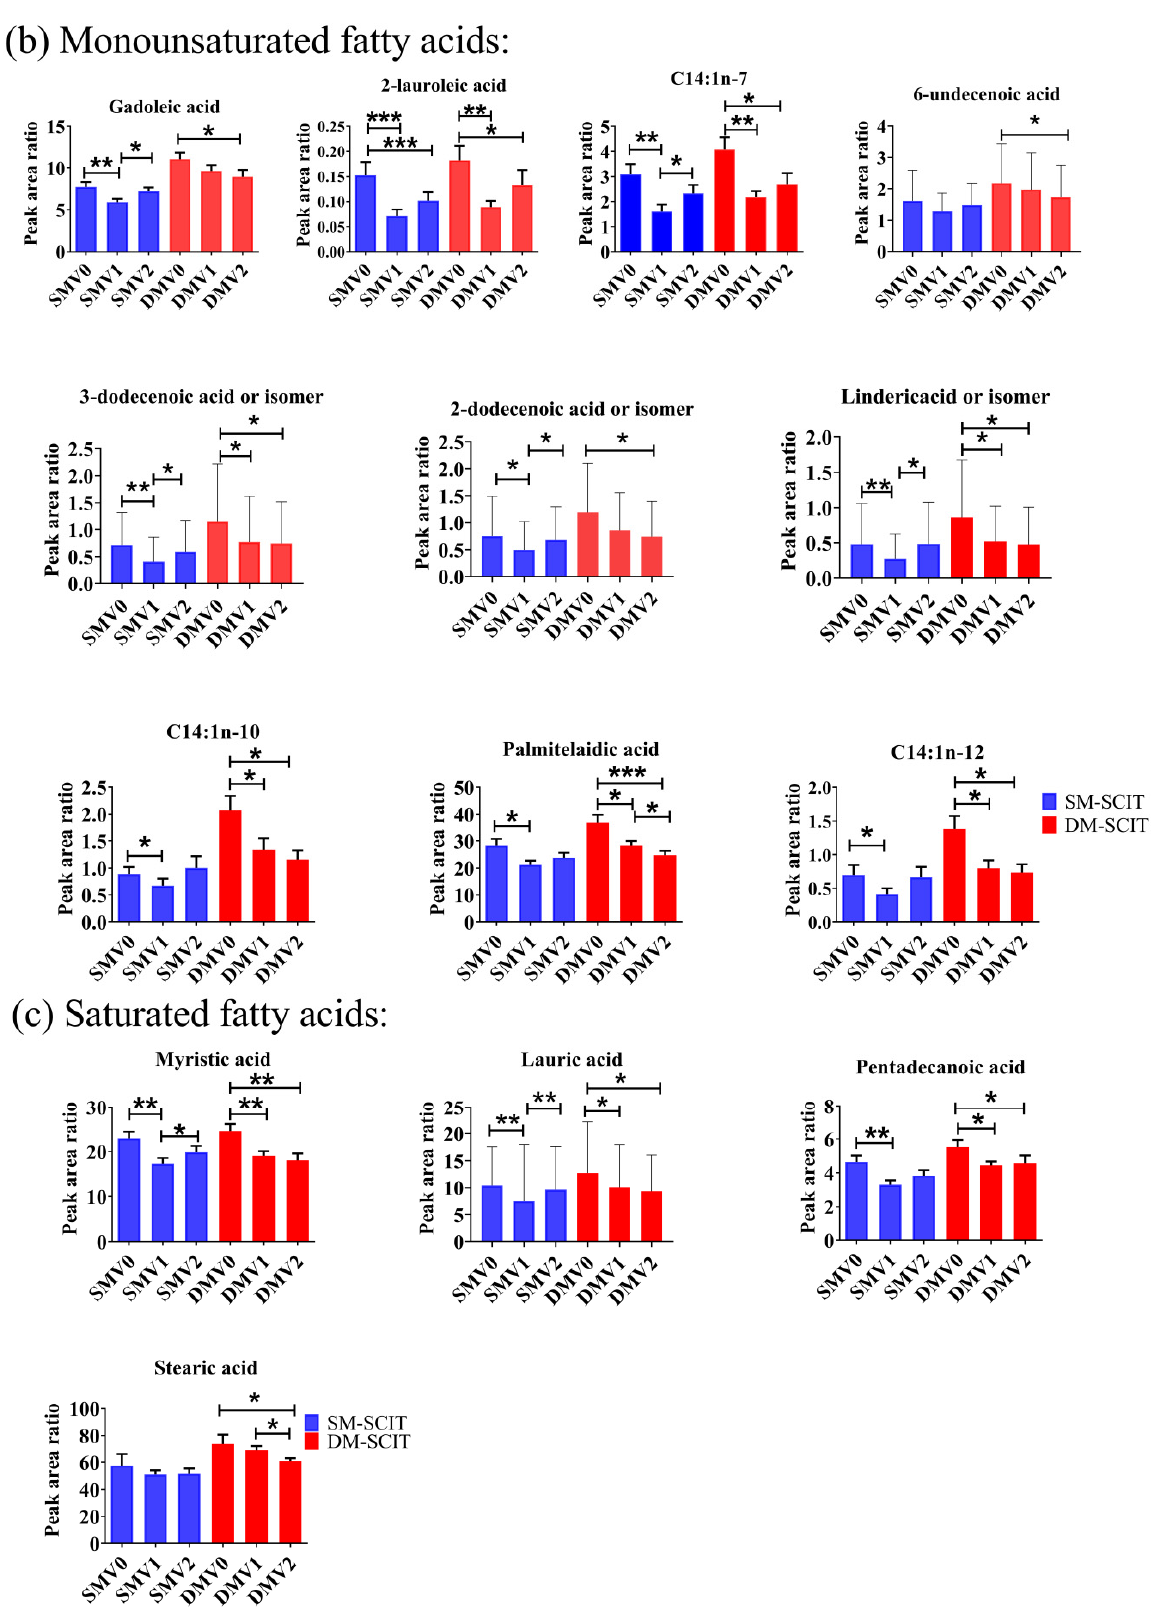
Figure 3. Comparison of the concentration of metabolites in patients: ( a ) polyunsaturated fatty acids metabolites, ( b ) mo- nounsaturated fatty acids metabolites and ( c ) saturated fatty acids metabolites. Blue column, SM-SCIT; red column, DM-SCIT. All results were expressed as mean ± SD (standard deviation), *, p < 0.05; **, p < 0.01; ***, p < 0.001.